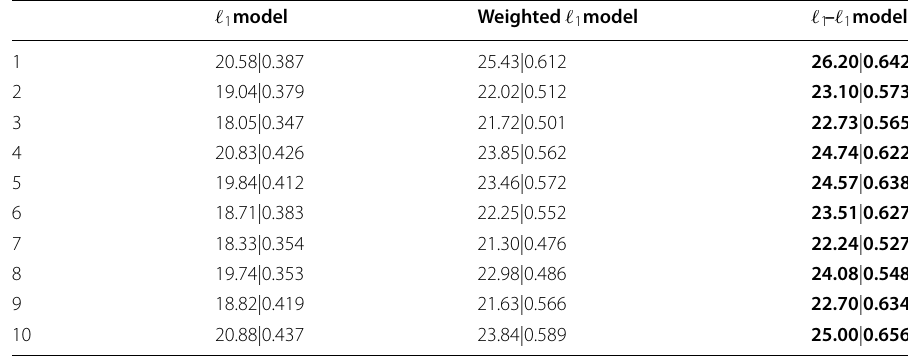
Table 1 PSNR|SSIM performance of ten images by four different